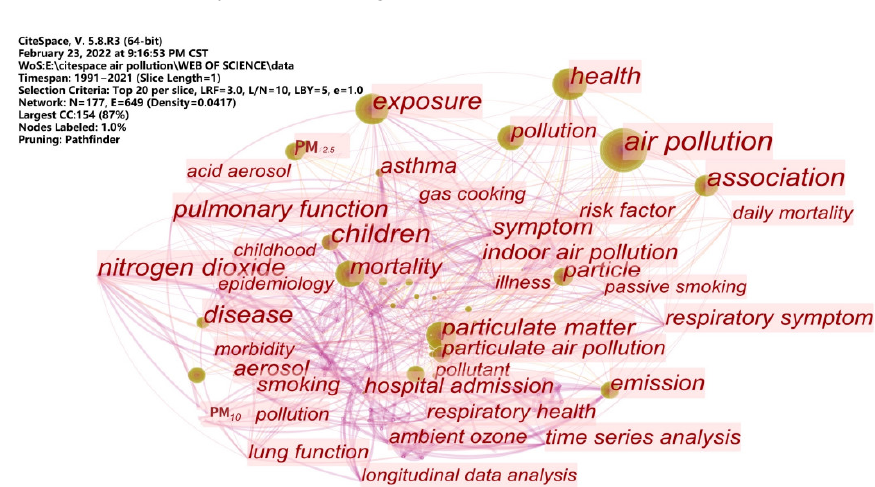
Figure 9. Co-occurring knowledge map of English literature keywords. Table 1. Highly cited Chinese literature.